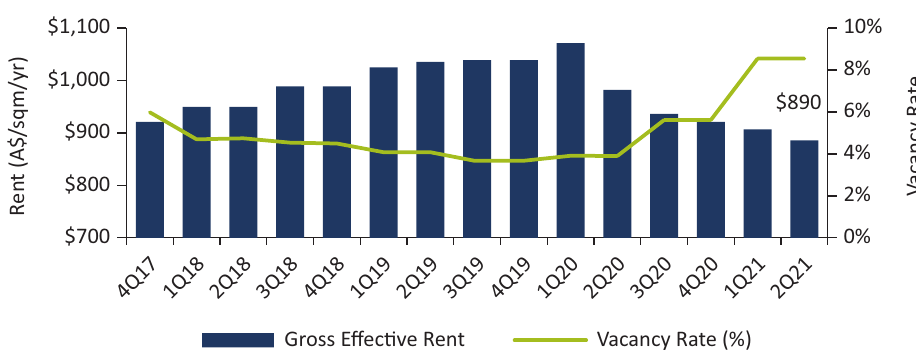
Figure 7. Prime gross effective rent price and overall vacancy (six‐monthly) in Sydney from the fourth quarter of 2017 to the second quarter of 2021. Source: Cushman & Wakefield (2021).